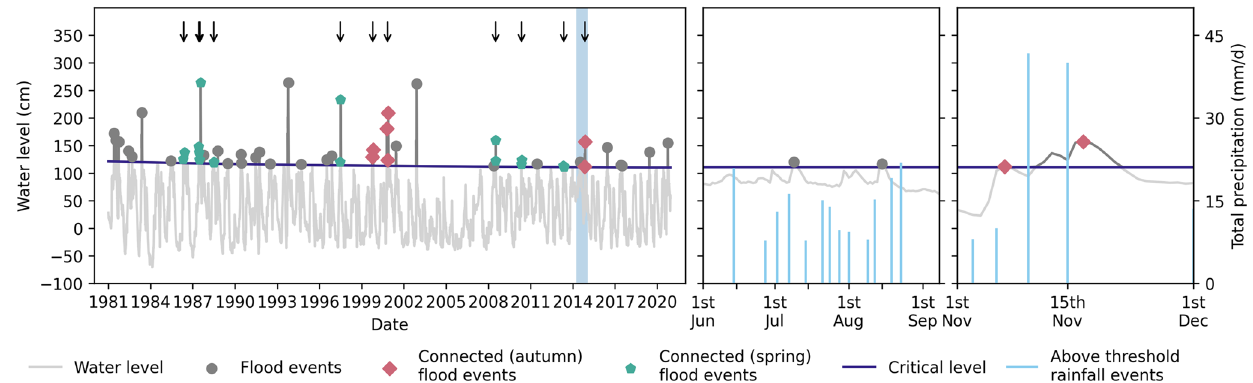
Fig. 5 Series of lake level and fl ood events. On the left, the lake level series with the maximum peak of fl ood events highlighted by dots. The purple line indicates the fl ooding level. In case of a connection between fl ood events, an arrow is drawn pointing to it. On the centre a zoom over the spring of 2014 during which two fl ood events occurred, but no in fl uence of the fi rst one on the second one was observed. On the right a zoom over the autumn of 2014 during which two fl ood events occurred, and a connection between them was identi fi ed.